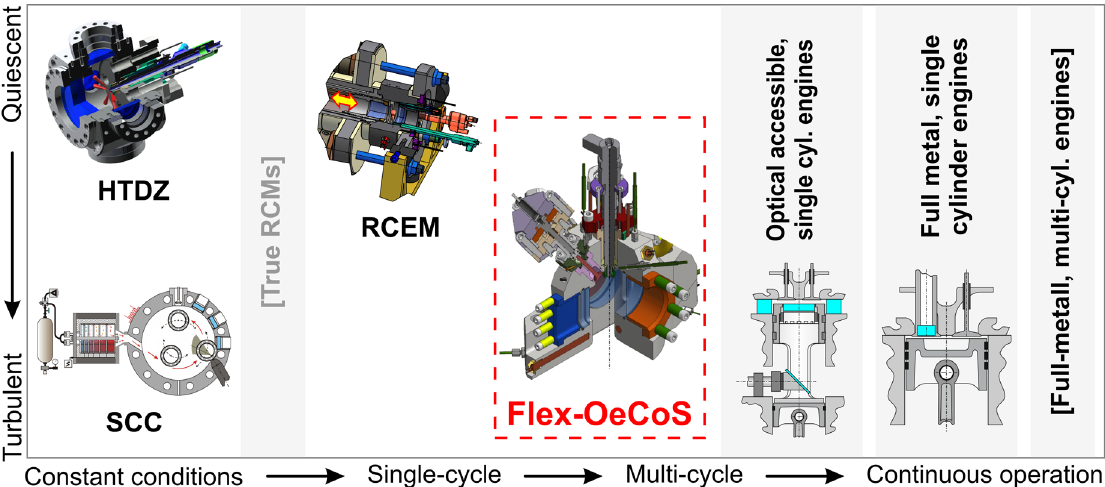
Figure 2. The new test rig (Flex-OeCoS) in the context of other, already existing test facilities at the involved research institutes. True RCMs (rapid compression machines) that lock the piston at top dead center position are not available.